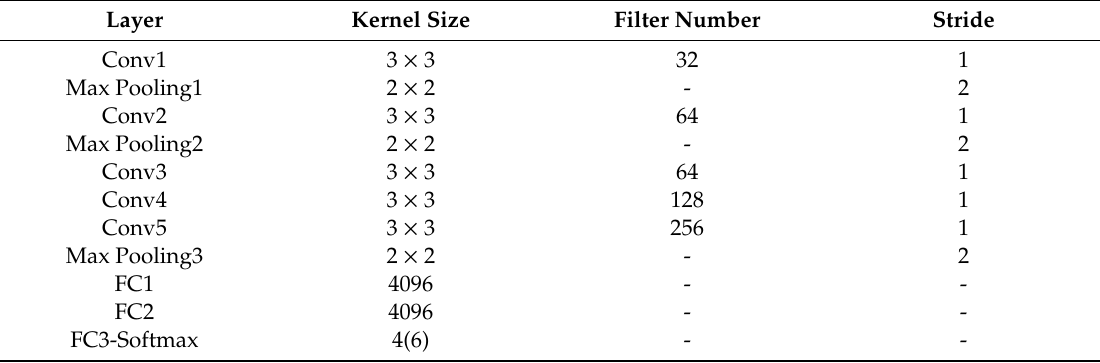
Table 3. Structure of fine-AlexNet